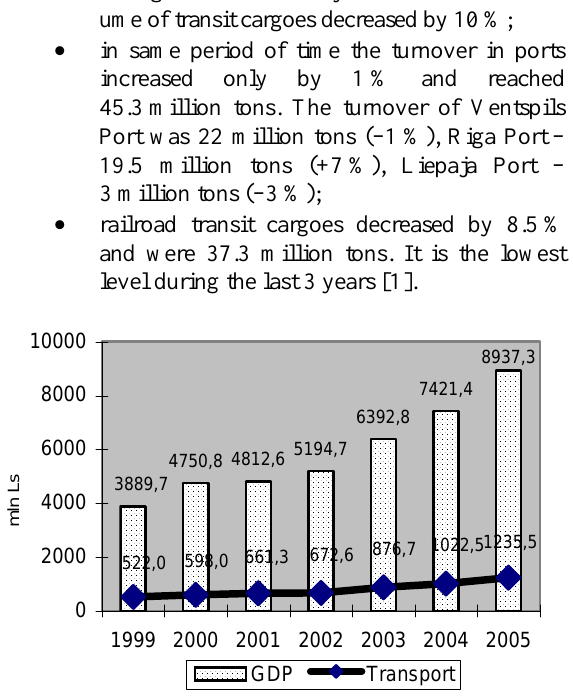
Fig 1. The proportion of transport revenue in GDP in Latvia from 1998 to